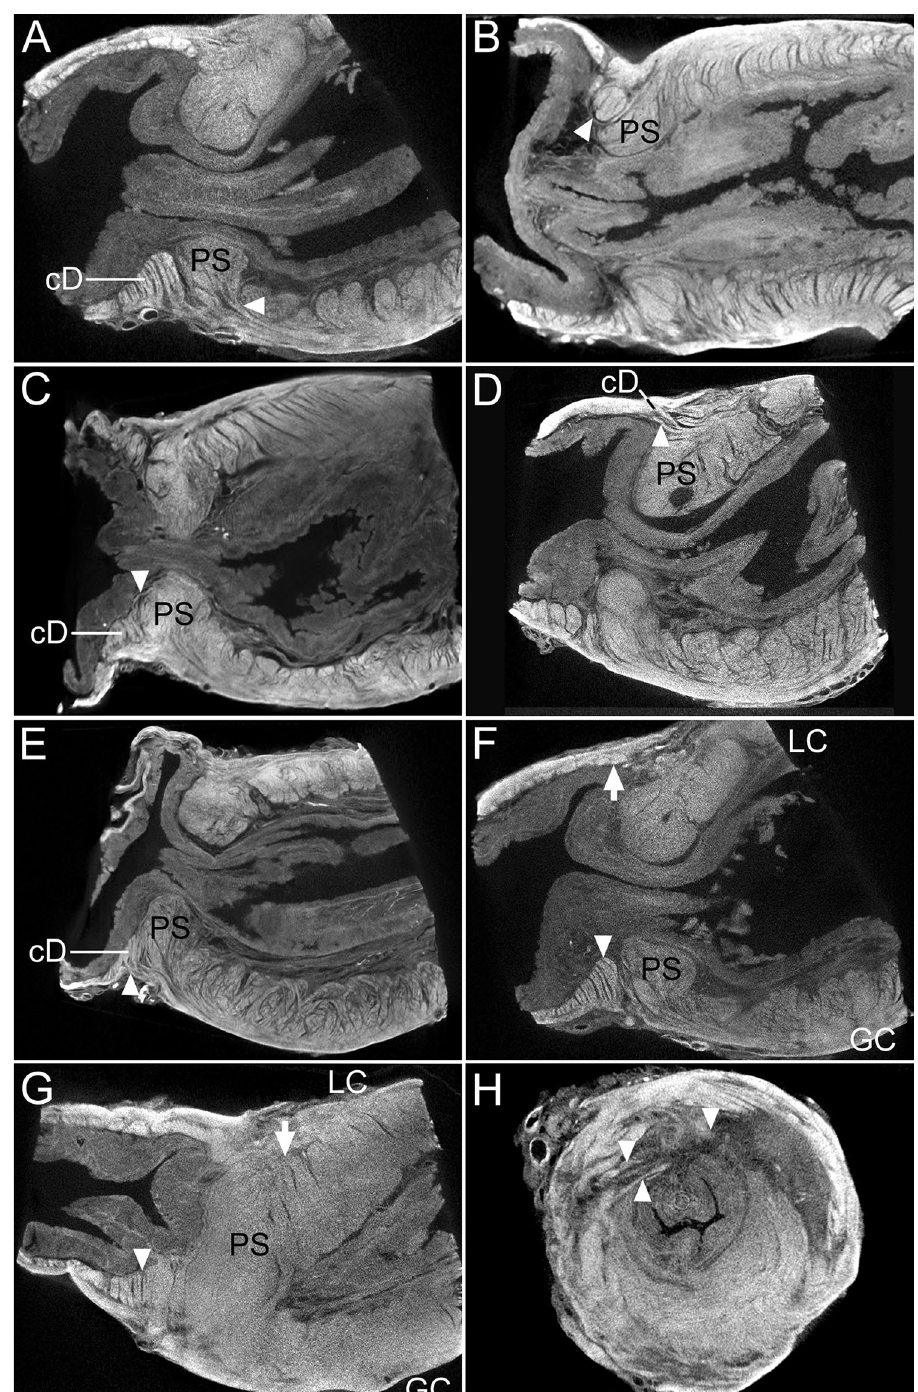
Figure 6. Microcomputed tomography images of the pyloric sphincter (PS). ( A ) Some outer longitudinal fibers (arrowhead) entered the PS in the longitudinal plane. ( B ) Some longitudinal fibers (arrowhead) entering the PS were connected to the aboral circular PS bundles in the longitudinal plane. ( C ) Some inner longitudinal bundles (arrowhead) were divided at the internal surface of the intermediate PS wall to connect to the circular bundles of the duodenum (cD) (arrowhead), adjacent to the PS in the longitudinal plane. ( D ) Some inner longitudinal bundles (arrowhead) that divided at the internal surface of the aboral end of the PS wall were connected to the cD adjacent to the PS in the longitudinal plane. ( E ) Some outer longitudinal bundles (arrowhead) were connected to the cD adjacent to the PS. ( F ) The cD (arrowhead) adjacent to the PS on the greater curvature (GC) side were thicker than those (arrow) on the lesser curvature (LC) side in the longitudinal plane. ( G ) In the longitudinal plane, the thick PS layer (arrow) on the LC side, and the thick duodenum muscular layer (arrowhead) on the GC side were successively arranged, crossing the gastroduodenal junction in the longitudinal plane. ( H ) In the axial plane, some muscles bundles (arrowheads) between the PS and duodenum were arranged